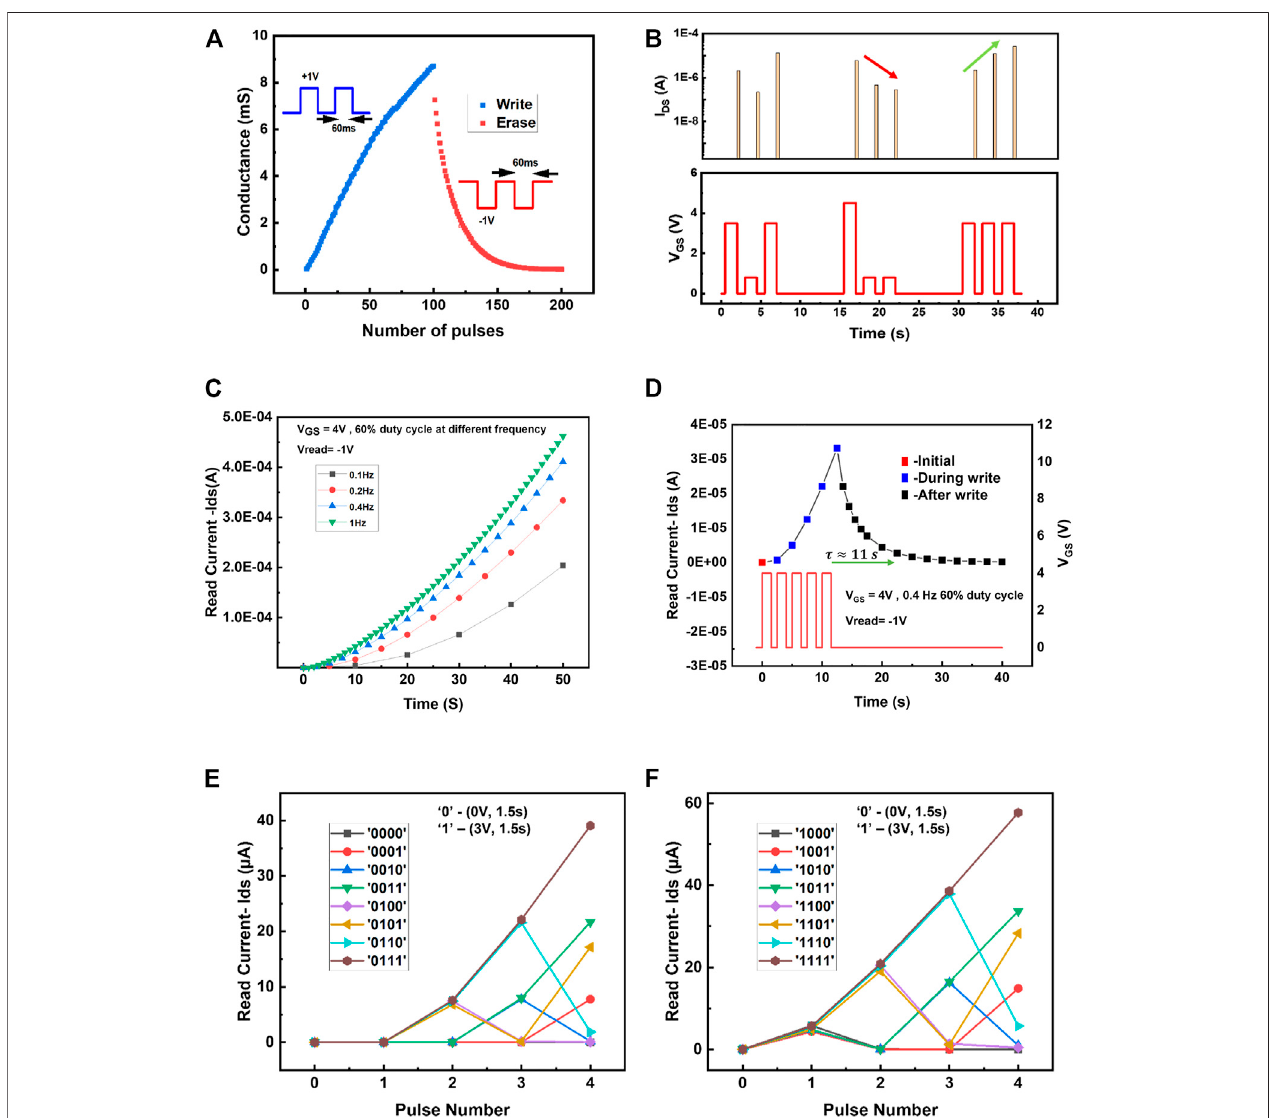
FIGURE 2 | (A) Measured conductance values of the SE-FET, showing gradual changes of conductance upon application of positive write pulses (+1 V, 60 ms) and negative erase pulses ( − 1 V, 60 ms). (B) Response of a SE-FET to a pulse stream with different time intervals between pulses. (C) Potentiation in a SE-FET at different frequencies shows devices do not get saturated even after multiple write pulses. (D) Conductance decay in the SE-FET. The device was fi rst programmed by fi vewritepulsesof4 Vat0.4 Hzwith60%dutycycle,subsequenttoitsconductance,measuredbyreadpulsesof − 1 V. (E) TheSE-FETresponsewhensubjected to the fi rst eight temporal inputs, shows the uniqueness of the output. For input “ 1 ” , a 3 V pulse at 0.4 Hz with 60% duty cycle and for input “ 0 ” no pulse was used. (F) Uniqueness of the output response to the streaming of a combination of eight inputs with identical setup.